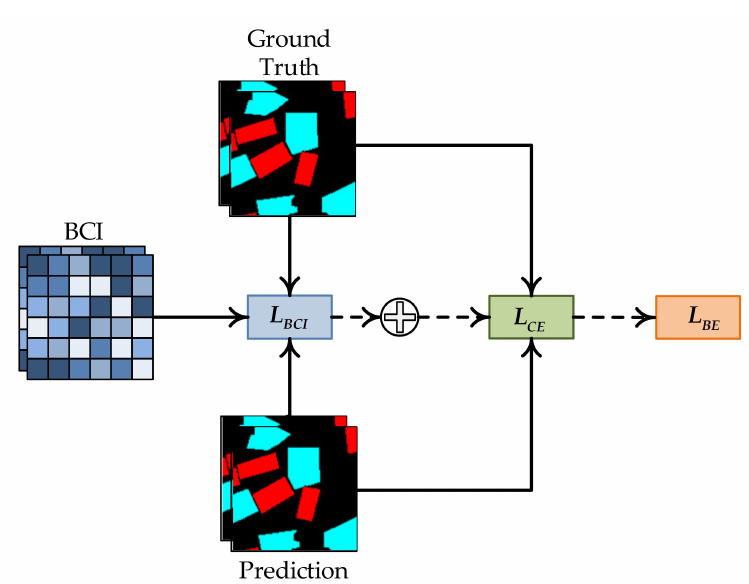
Figure 6. Schematic diagram of the proposed BE